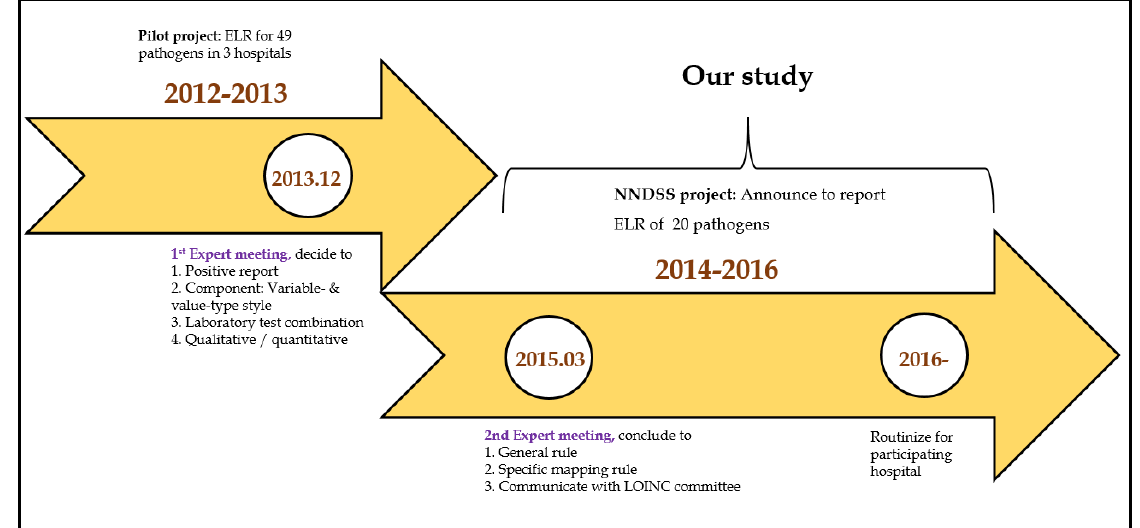
Figure 2. Timeline for NNDSS.